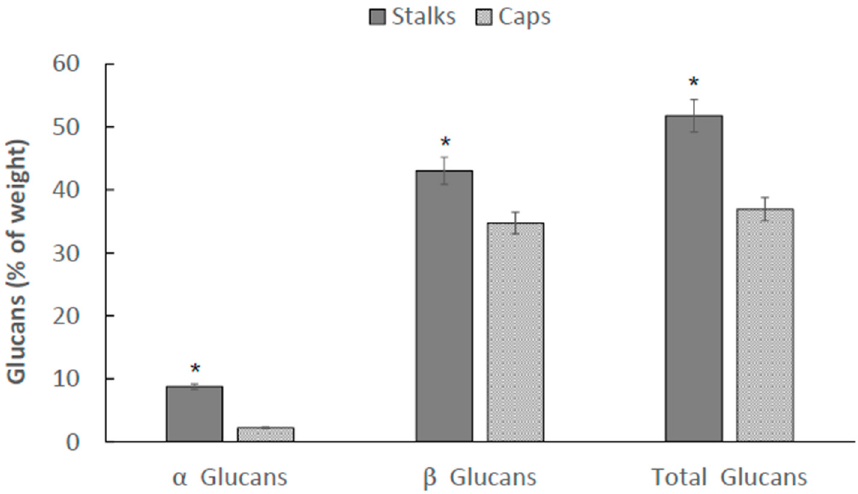
Figure 2. α , β , and total glucan concentrations in caps and stalks of the mushroom strain Pleurotus eryngii . * p < 0.01 stalks as compared to caps.